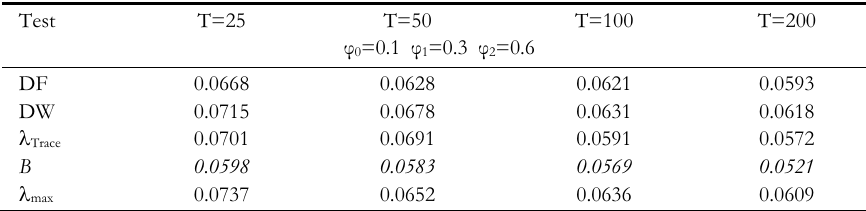
=0.3 (cid:438) 2 =0.65) (cid:1187)